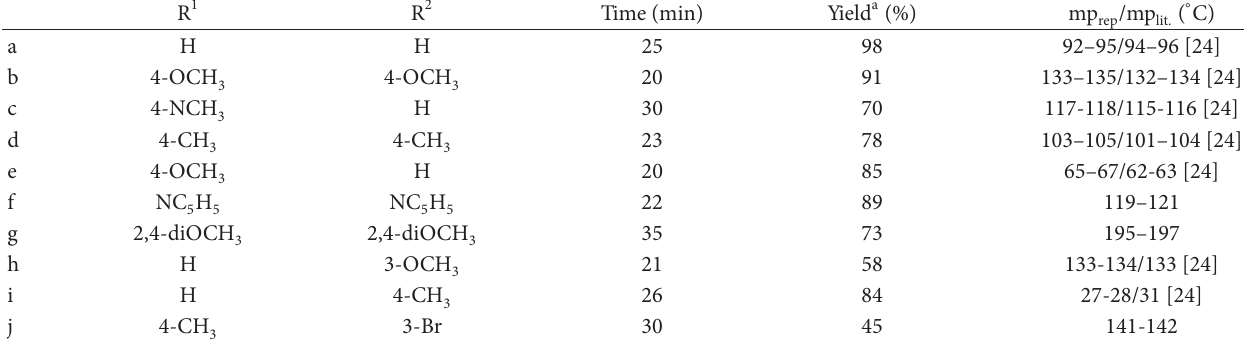
O in the presence of Mn(II) Schiff base complex in CH 2 2